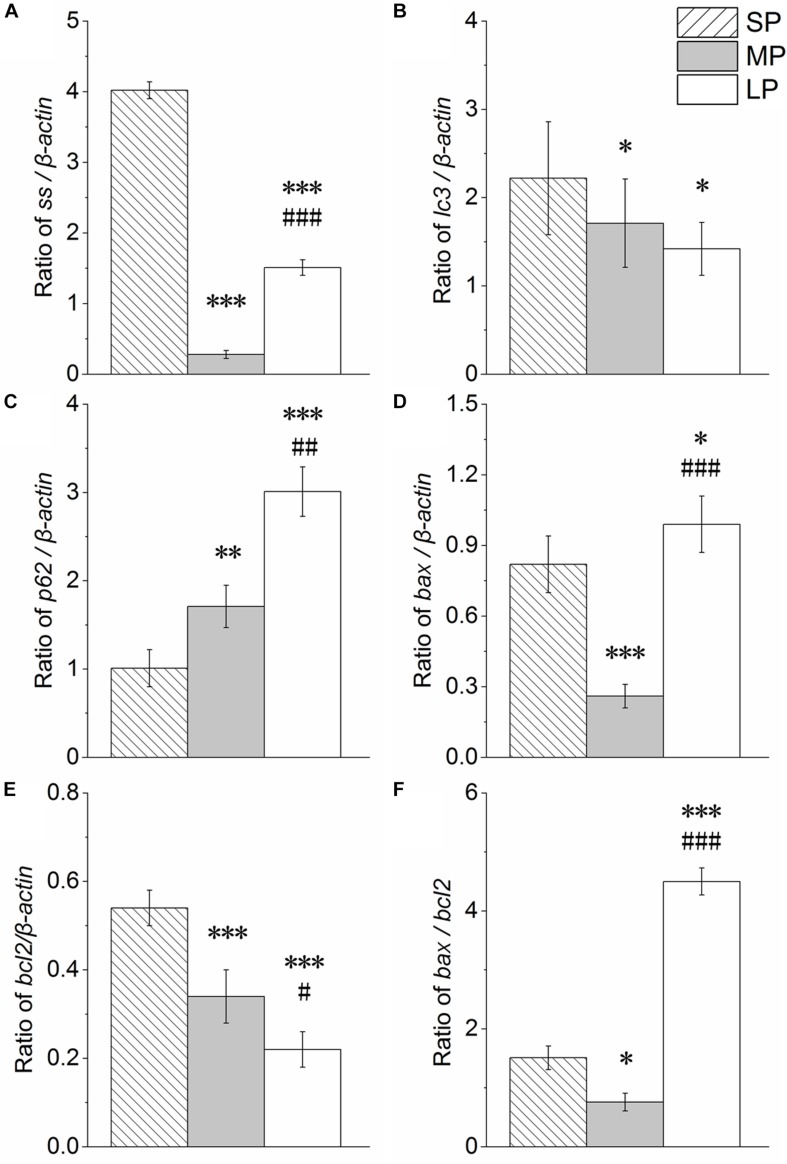
Changes in mRNA levels of ss, lc3, p62, bax, bcl2, and bax/bcl2 in HG of hamsters in three different photoperiodic groups. (A) Ratio of ss to β-actin. (B) Ratio of lc3 to β-actin. (C) Ratio of p62 to β-actin. (D) Ratio of bax to β-actin. (E) Ratio of bcl2 to β-actin. (F) Ratio of bax to bcl2. Values are means ± SD. n = 10. SP, short photoperiod; MP, moderate photoperiod; LP, long photoperiod. ∗P < 0.05, ∗∗P < 0.01, ∗∗∗P < 0.001 compared with SP; #P < 0.05, ##P < 0.01, ###P < 0.001 compared with MP.